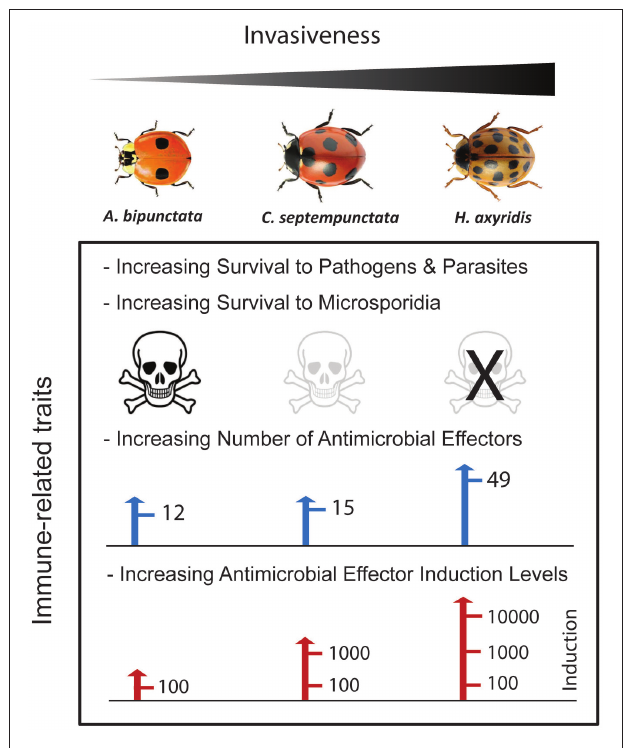
FIGURE 2 | Relationship between immune-related traits, pathogen resistance and invasiveness in three ladybeetle species: A. bipunctata, C. septempunctata, and H. axyridis . As the number and inducible expression levels of AMPs increase, the greater the resistance against pathogens and parasites, and the greater the invasive